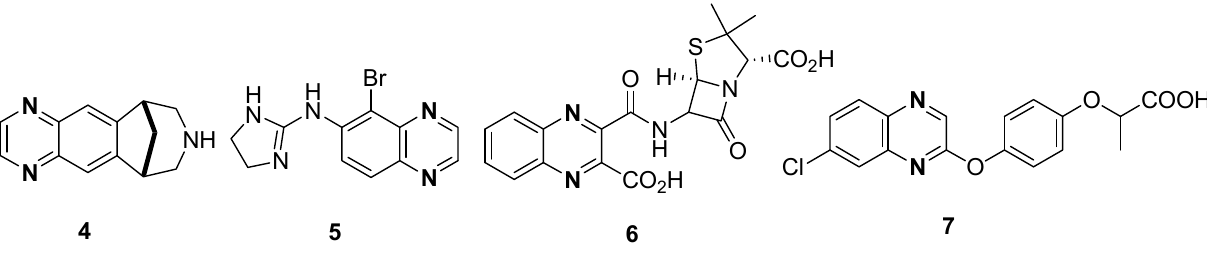
Figure 2. Structures of quinoxaline drugs 4–7.